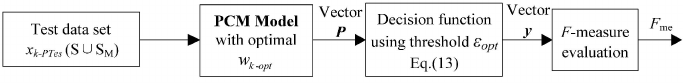
Figure 6. Evaluation of proposed